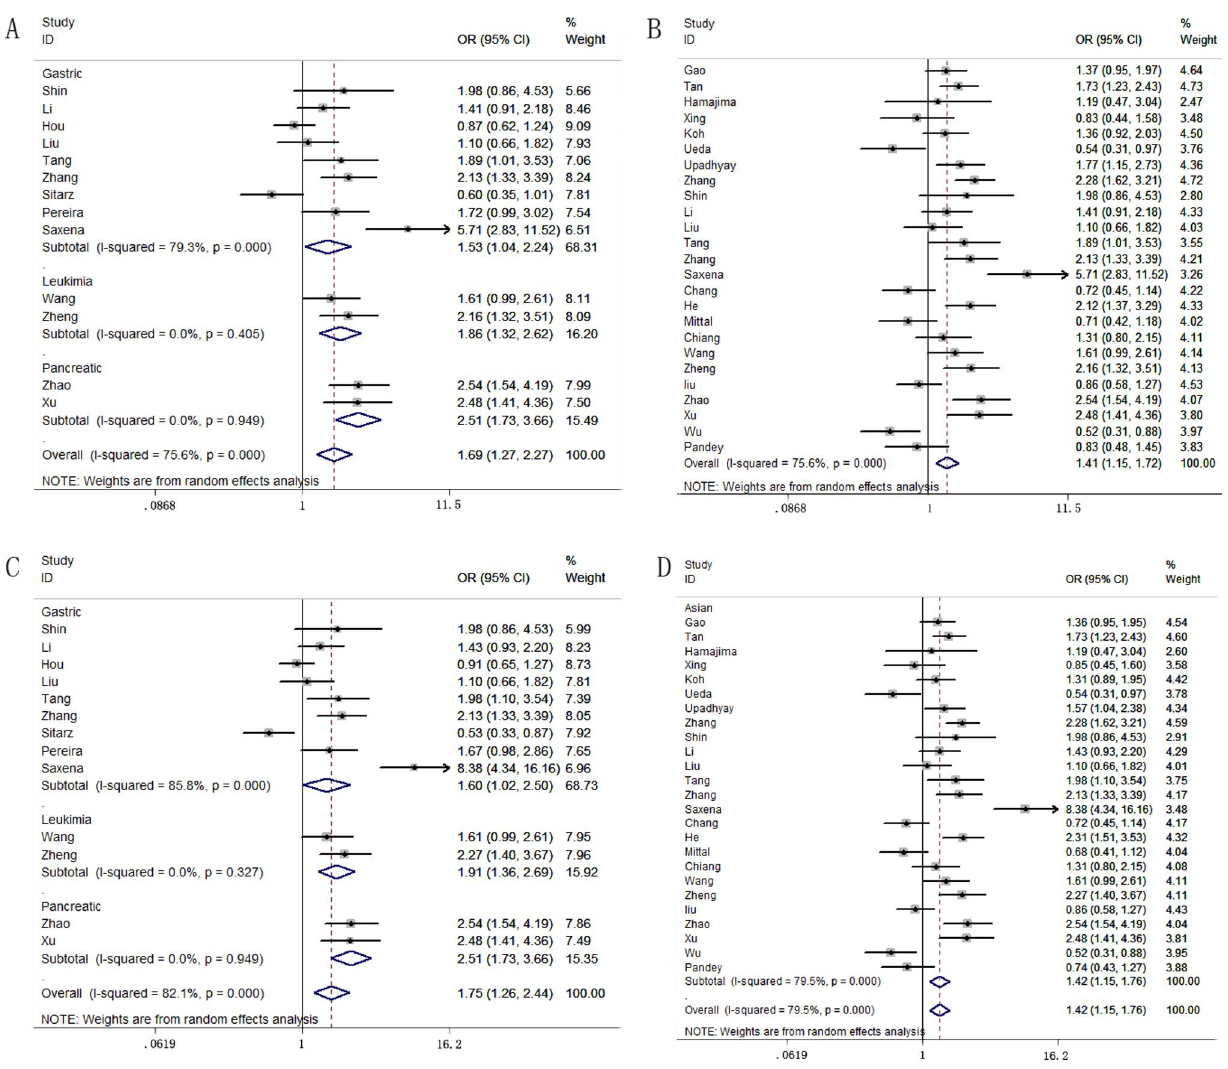
Figure 2. Forest plot of cancer risk associated with the COX-2-765 G . C polymorphism stratified by cancer type and ethnicity. GC vs. GG in the co-dominant model by the random effects for (A) gastric cancer, leukemia, pancreatic cancer and (B) in the Asian population. (CC + GC) vs. GG in a dominant model by the random-effects for (C) gastric cancer, leukemia, pancreatic cancer and (D) in the Asian population.